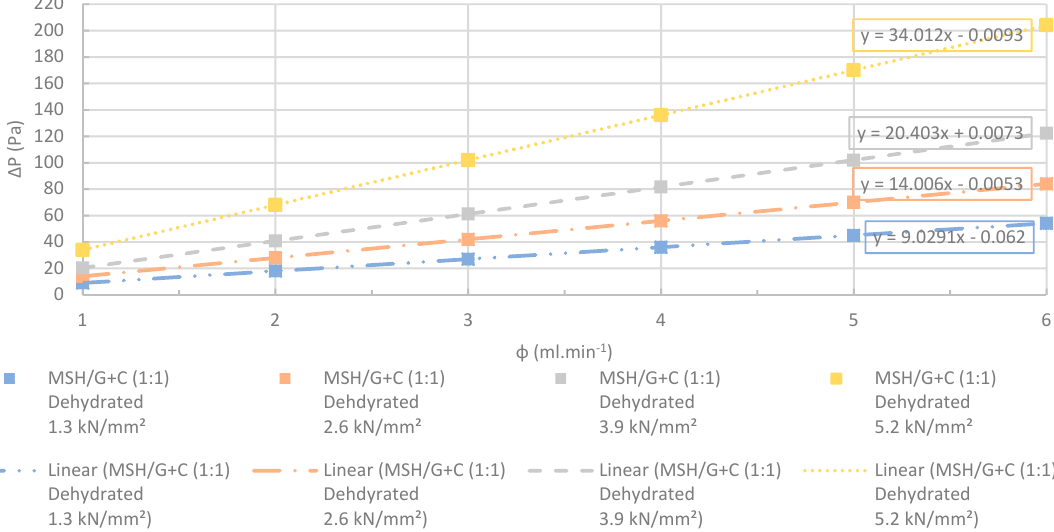
Figure 27. Changes at differential pressures of MSH/G+C (1:1) pellets with increasing flow rates. R 2 > 0.99. The accuracy of the pressure measurements was less than 0.1%.